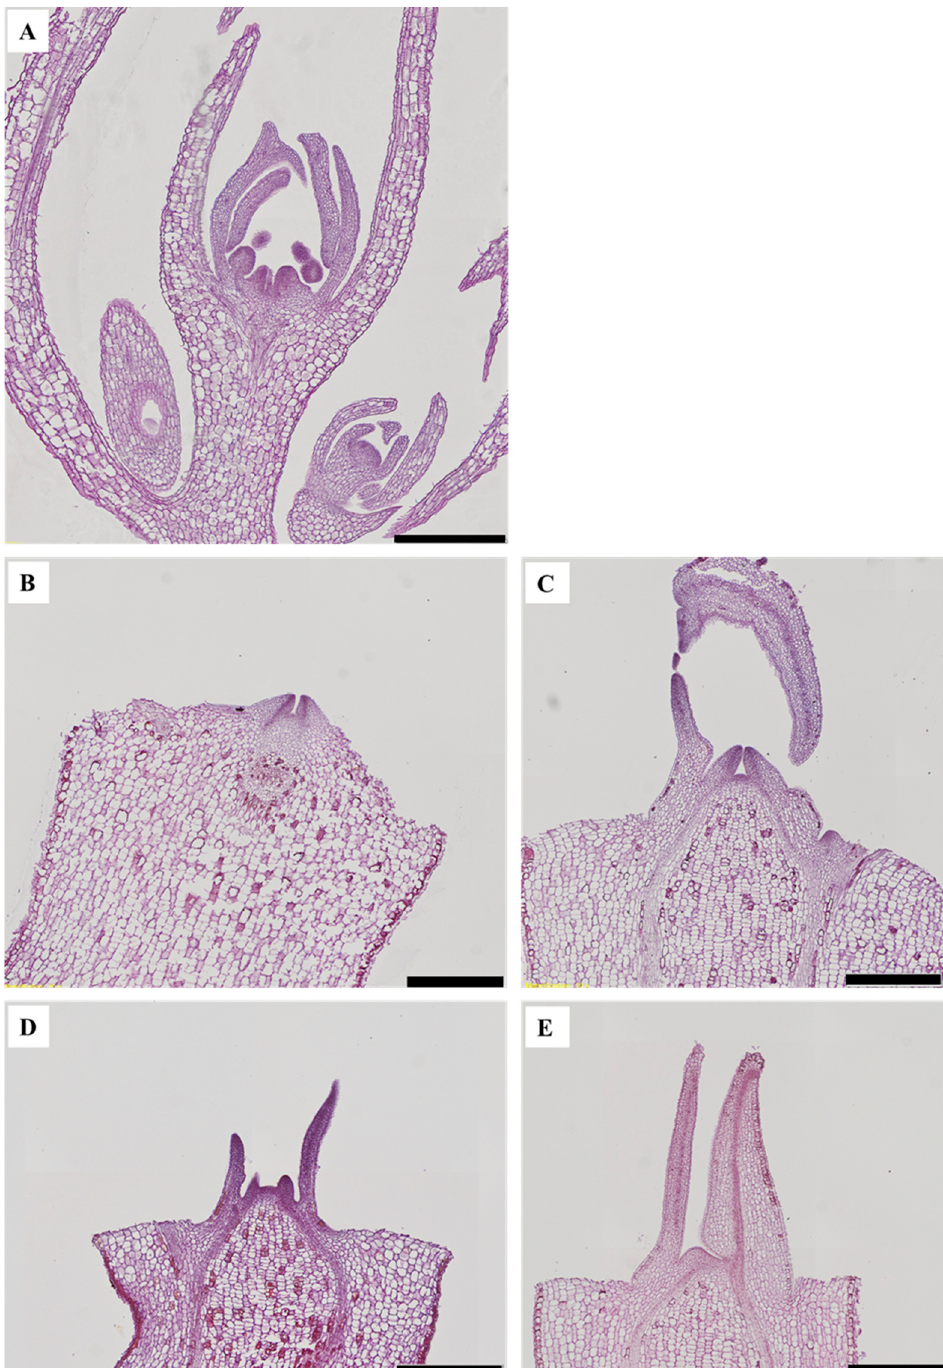
Figure 7. The vertical section of the terminal buds of kalanchoe ( Kalanchoe blossfeldiana ) ‘Spain’ grown under NI-B at 10 (A) or 20 (B) μ mol·m -2 ·s -1 PPFD; NI-R (C), NI-W (D), and NI-BW (E) at 20 μ mol·m -2 ·s -1 PPFD for 53 days. Please refer to Figure 1 for details on the NIL quality. Scale bar indicate 500 μ m.